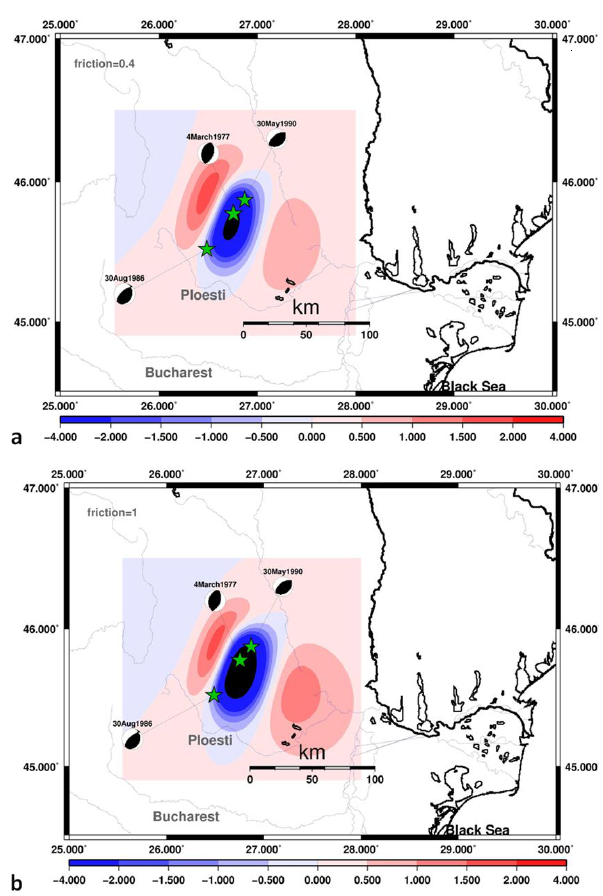
Fig. 5. Map of Coulomb stress due to the 1977 earthquake for 1986- type receiver faults at the depth of 131km (hypocentral depth of the 1986 event) in the case of (a) effective friction 0.4 and (b) 1. Colour palette of stress values is linear in the range of − 4 to +4bar (1bar=100kPa). Black colour indicates area where transferred stress < − 4bar. Green stars show the earthquake